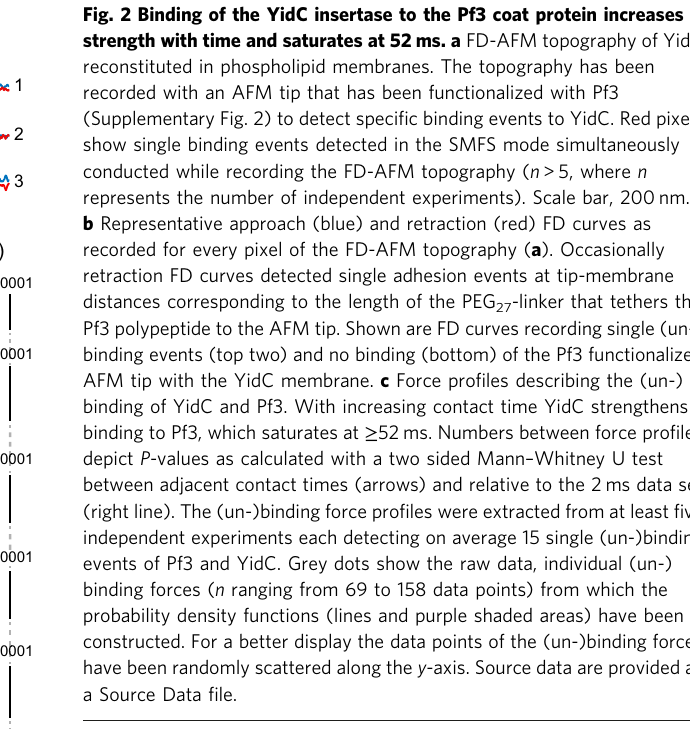
independent experiments each detecting on average 15 single (un-)binding events of Pf3 and YidC. Grey dots show the raw data, individual (un-) binding forces ( n ranging from 69 to 158 data points) from which the probability density functions (lines and purple shaded areas) have been constructed. For a better display the data points of the (un-)binding forces a Source Data fi